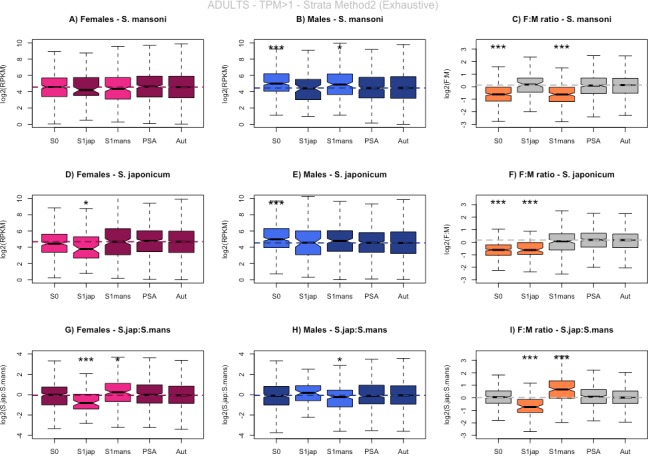
Adult expression patterns (TPM>1, exhaustive strata) of genes located in the different strata of the Z (S0, S1man and S1jap), as well as pseudoautosomal and autosomal genes.The distribution of expression values is shown for (A) S. mansoni females, (B) S. mansoni males, (C) S. mansoni female:male, (D) S. japonicum females, (E) S. japonicum males, (F) S. japonicum female:male, (G) Female expression in S. japonicum divided by female expression in S. mansoni, (H) Male expression in S. japonicum divided by male expression in S. mansoni, (I) female:male ratio of expression in S. japonicum divided by female:male ratio of expression in S. mansoni. Asterisks represent levels of significance of comparisons to the control autosomal genes (*p-value<0.05, **p-value<0.001, ***p-value<0.0001). Genes were assigned to each Z-chromosome stratum based only on their coverage patterns; only genes with TPM >1 were used.